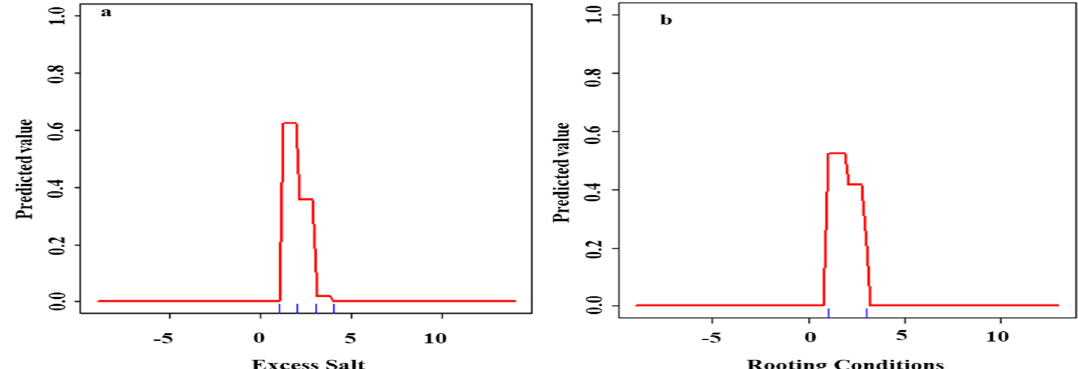
Fig. 8 Receiver operating characteristics curve (ROC) illustrating relationship between probability of occurrence of suitable conditions for distribution of C. wightii with most significant soil quality predictors excess salt ( a ) and rooting conditons ( b